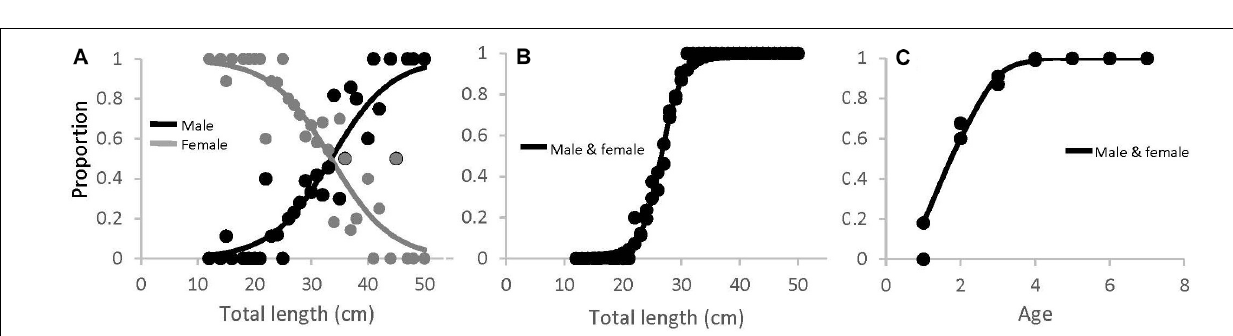
FIGURE 7 | Mean ( ± 1 SE) values of Kadj (dashed line) and LSIadj (solid line) by 2 cm size bins for black sea bass from all regions combined.